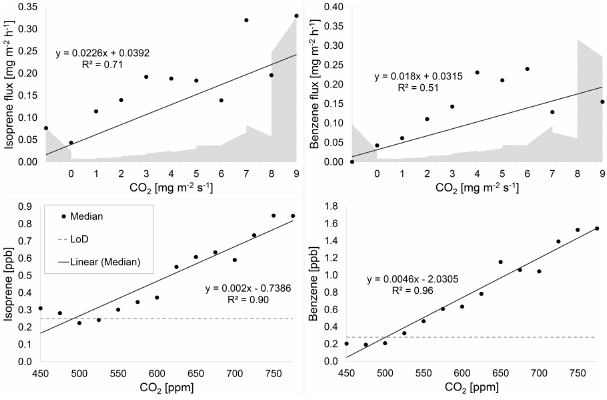
Figure 8. Scatter plots showing averaged flux and concentration re- gressions of isoprene and benzene as a function of CO 2 fluxes and concentrations based on 25min VOC means with linear regressions, formulae, R 2 values and detection limit (shaded area for fluxes and dashed line for mixing ratios).